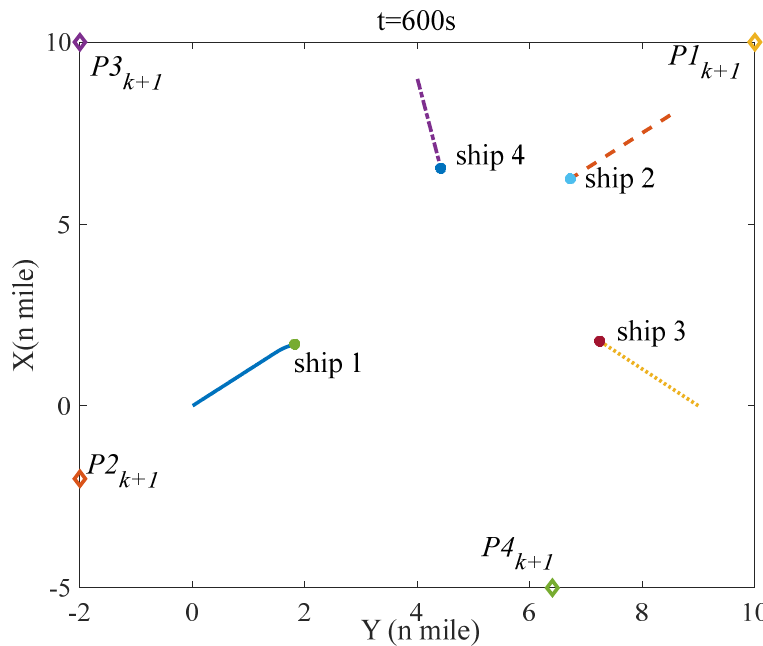
Figure 19. The situation of four ships at t = 600 s in scenario 3.